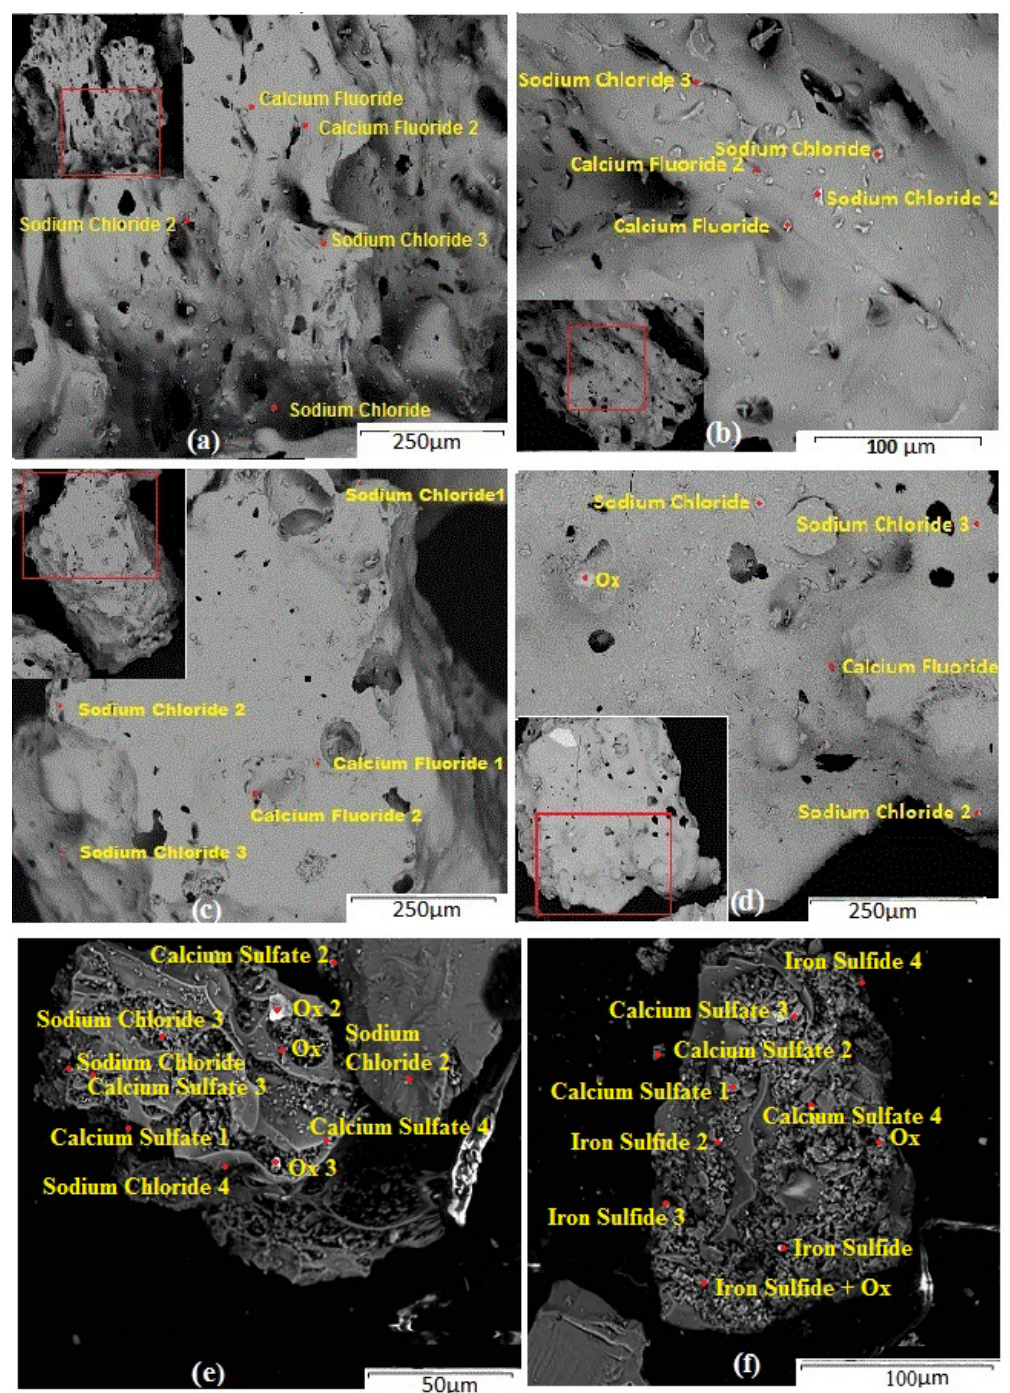
Figure 4. SEM-BSE images of fresh ash particles from Etna 2011 (a, b) , Etna 2012 (c, d) , and Popocatépetl samples (e, f) . The insets indicate the investigated area. The detected sublimated salts are in